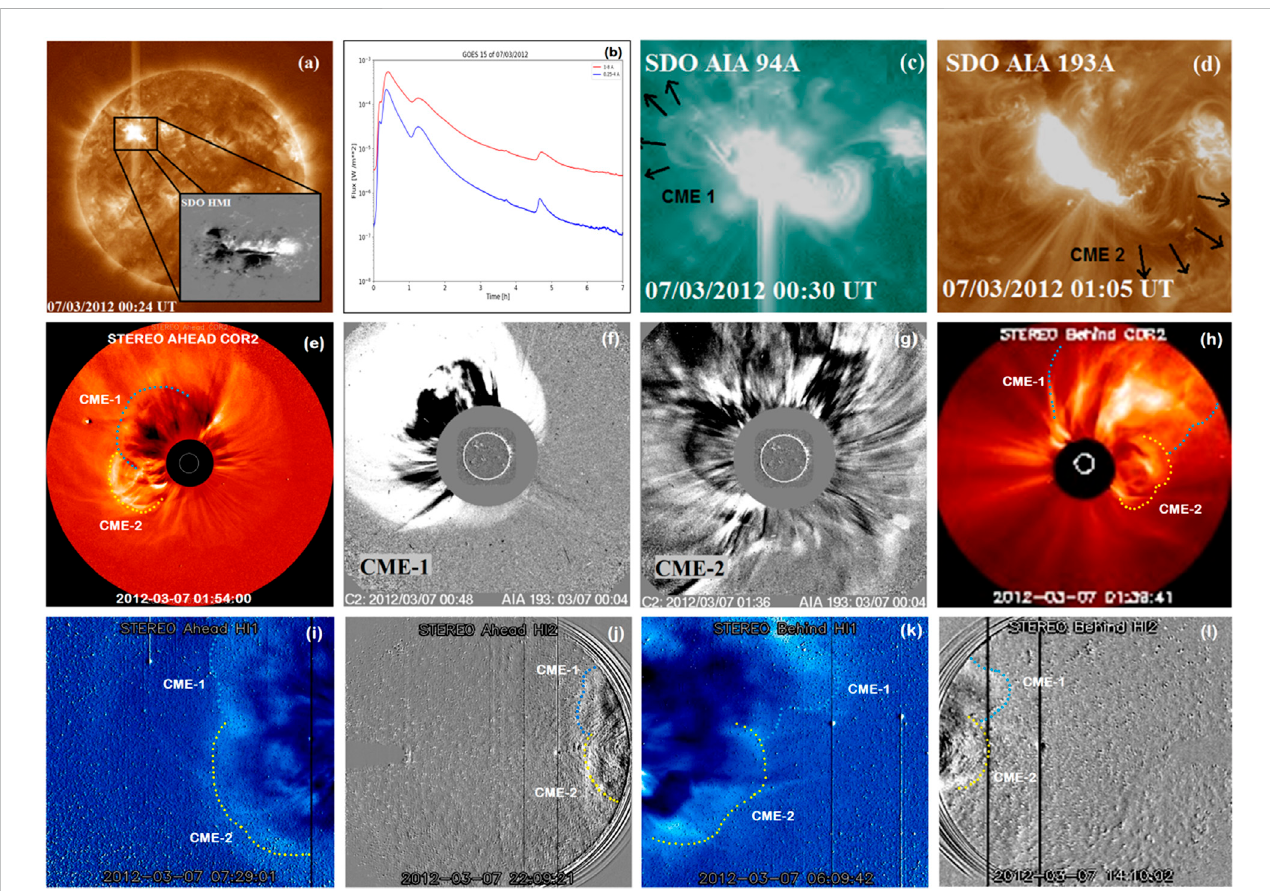
FIGURE 3 (A) SDO/AIA image of the solar disk on 7 March 2012 in the 94 Å and SDO/HMI fi lters (in highlighted square box). (B) Solar fl ares observed in 1 – 8 Å (red) and .25 – 4 Å (blue) wavelength bands by the X-ray sensor onboard the GOES satellite. (C) – (D) SDO/AIA EUV images in 94 Å and 193 Å fi lters showing the source location CME. The arrows represent the direction of CME ’ s fronts. Image (E) shows the reported CMEs in the fi eld of view of STEREO-A COR2 CME-2. Image (F) and (G) present the eruption of CME-1 and CME-2 observed by C2 coronagraph of LASCO/SOHO, respectively. Image (H) shows the reported CMEs in the fi eld of view of STEREO-B COR2. In the bottom panel, image (I – L) shows the propagation of merged CMEs in the heliosphere imaged in H1 and H2 fi eld of view of STEREO-A and STEREO-B (blue and yellow dotted curved lines represent the position of CME-1 and CME-2,